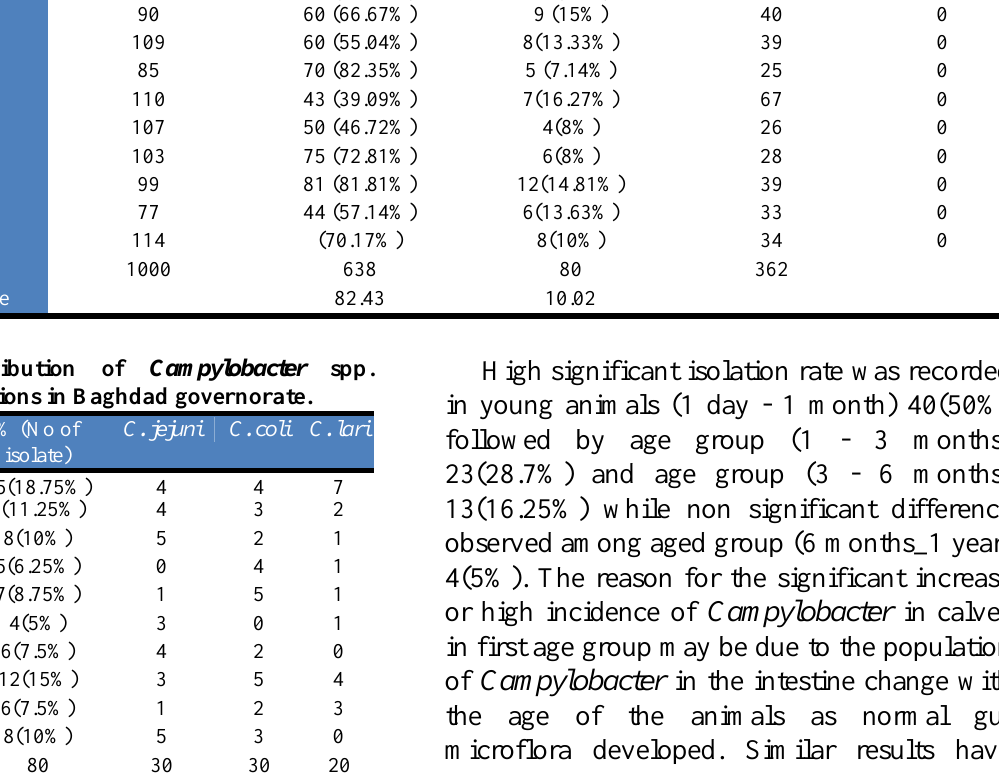
positive non diarrheic positive